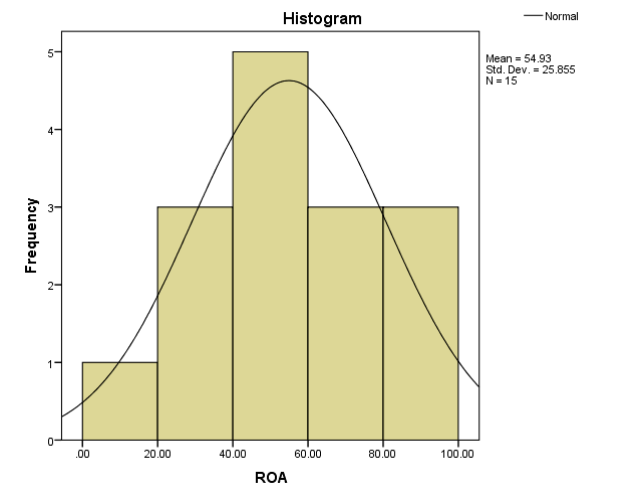
Figure 2. Normality test histogram for